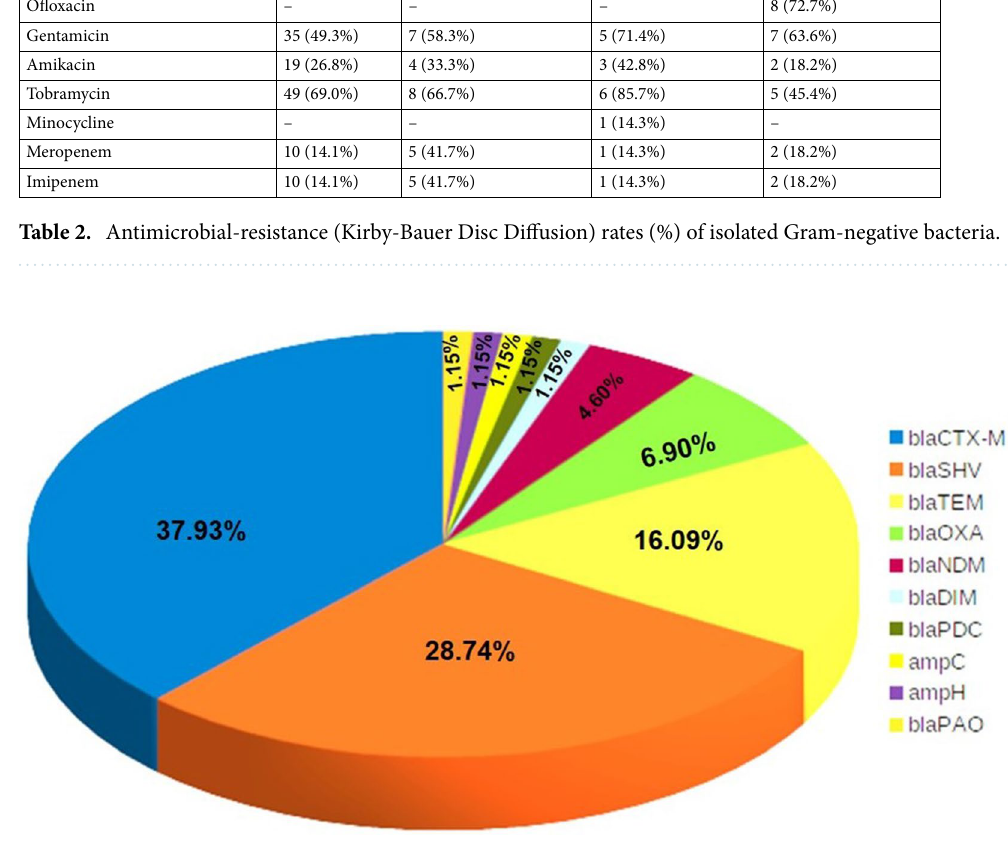
Figure 1. Types of carbapenem-resistance gene in Gram-negative